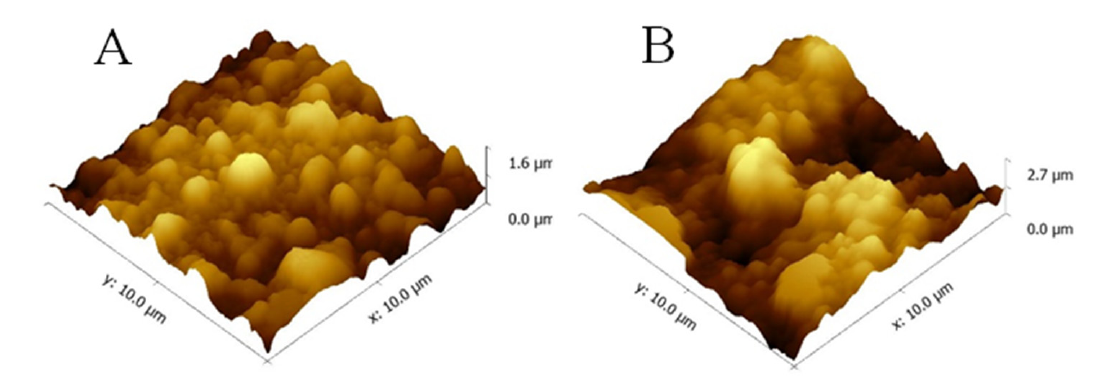
Figure 11. AFM morphologies of the PP-g-P (AAm-co-AN) sample in a plate with water at different temperatures: ( A ) at 20 ◦ C, and ( B ) at 40 ◦ C. The AAm grafting degree is 101%, and the AN concentration of PP-g-P (AAm-co-AN) is 23%.